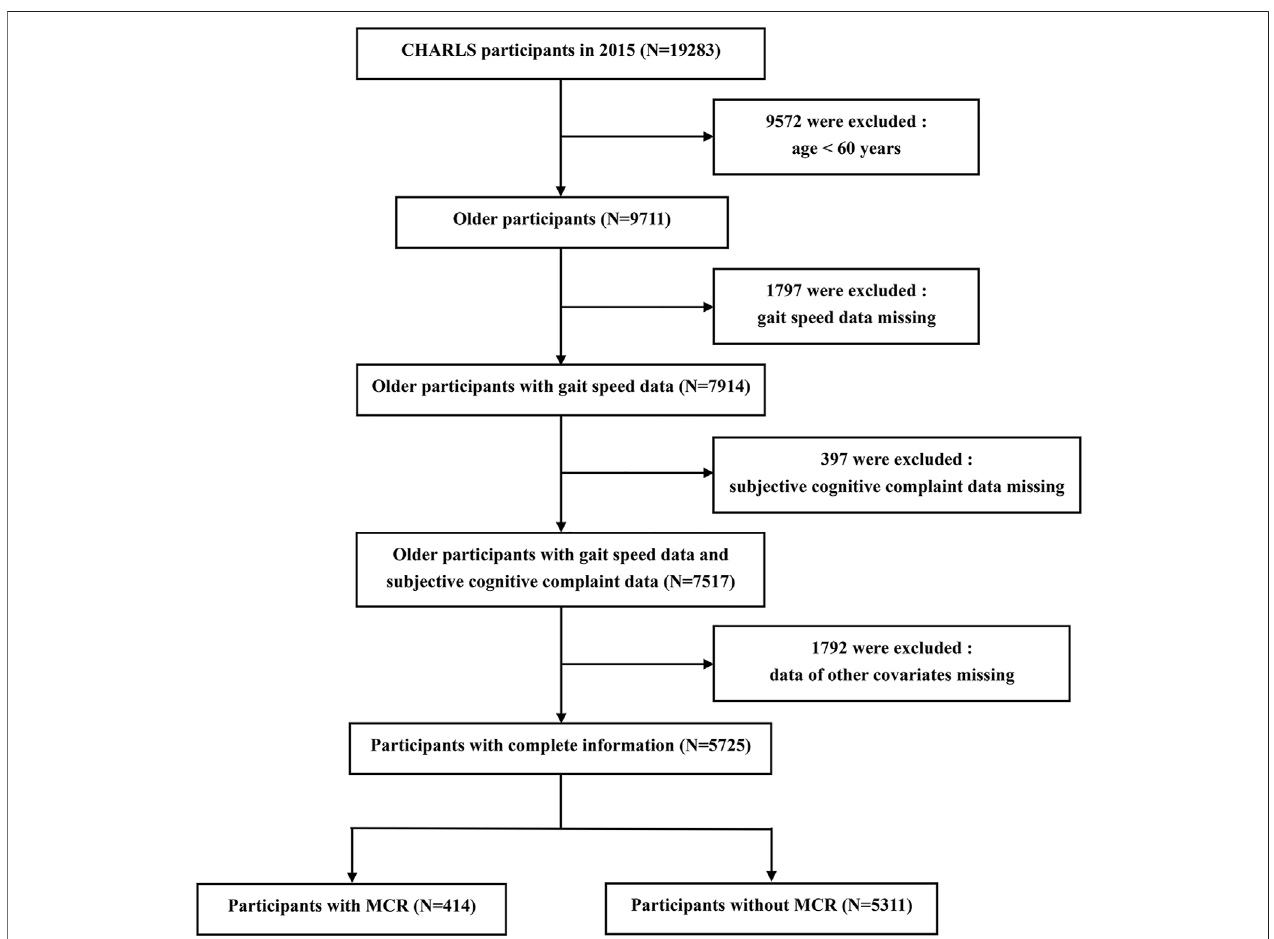
FIGURE 1 | Inclusion process of study